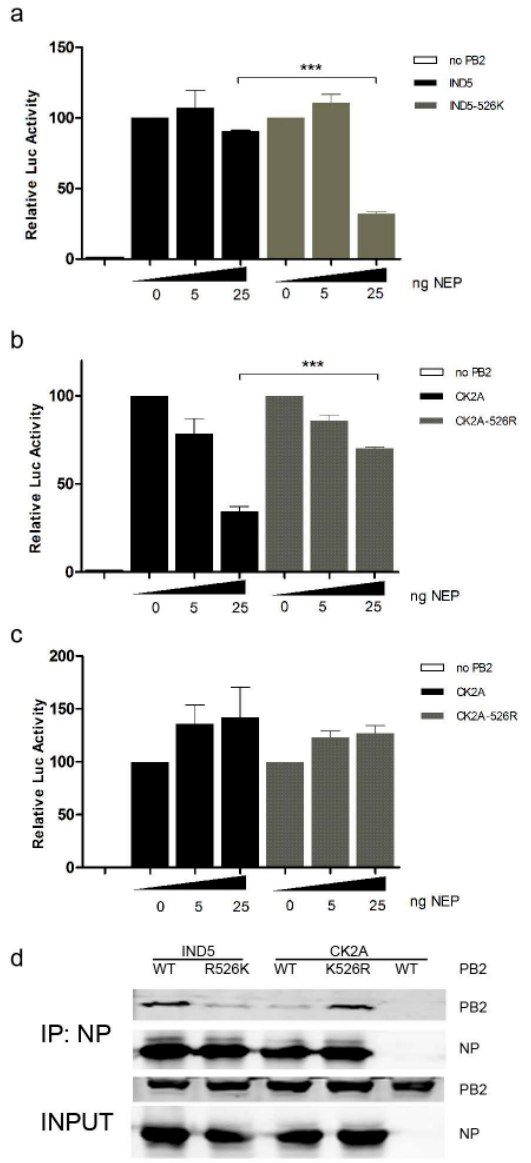
Figure 5. Effect of 526R PB2 on RNP activity in the presence of NEP and NP-PB2 interaction. Increasing amounts of NEP expression vector, or empty vector, were co-transfected with expression plasmids for the RNP complexes of IND5 and IND5-526K PB2 ( A ), or CK2A and CK2A-526R PB2 ( B ), together with RNP luciferase reporter and pRL-TK control plasmids, into HEK293T cells, followed by culture at 37 ◦ C. Similarly, RNP polymerase activity with the RNP complexes of CK2A and CK2A-526R and increasing amounts of NEP expression was examined in DF-1 cells, cultured at 39 ◦ C ( C ). Luciferase activities were measured at 24 h post transfection. Firefly RNP polymerase activity was normalized against Renilla activity, and RNP without PB2 was used as a negative control. Data represent mean normalized luciferase activity from three independent experiments. Error bars represent standard deviation from three separate experiments. Statistical significance was analyzed by Student’s t -test. *** p < 0.001. ( D ) Interaction between NP and PB2 in RNP complexes. Different sets of plasmids expressing PB1, PA, NP and Flag-tagged PB2 from IND5-526K or CK2A-526R, were transfected into HEK293T cells. At 48 h post transfection, cell lysates were prepared and rabbit polyclonal NP antibody used to co-precipitate PB2. Proteins from co-precipitated complexes were resolved using SDS-PAGE and detected by Western blot using anti-NP (1:5000) and anti-Flag (Sigma) (1:5000) antibodies.